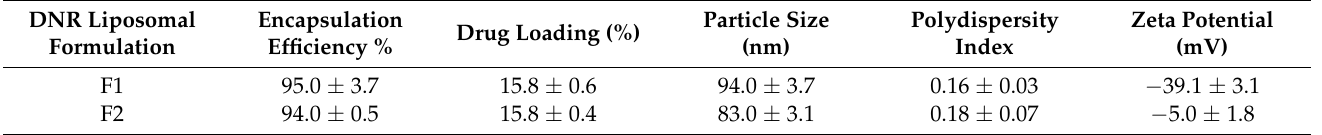
Table 2. Physicochemical characteristics of different liposome formulations. Values are expressed as mean ± SD, n =